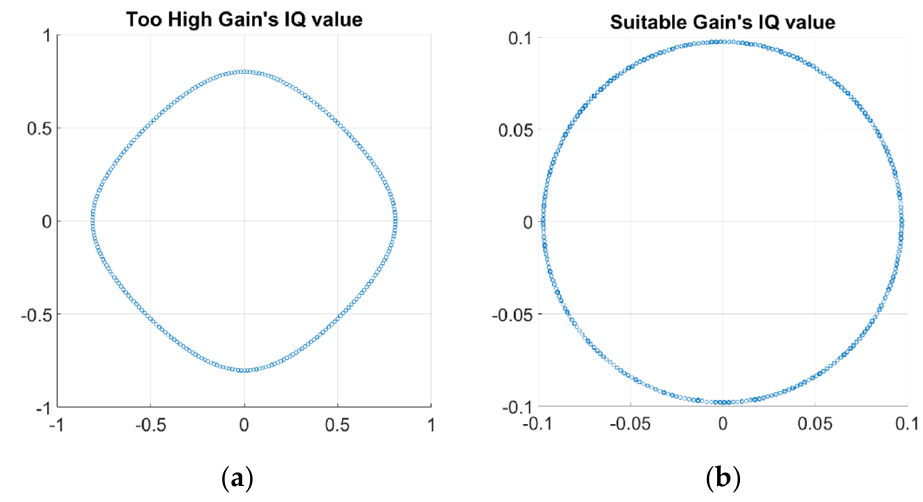
Figure 11. The received IQ plots for: ( a ) high gain setting and ( b ) suitable gain setting. Table 2. LimeSDR−mini parameters setting.